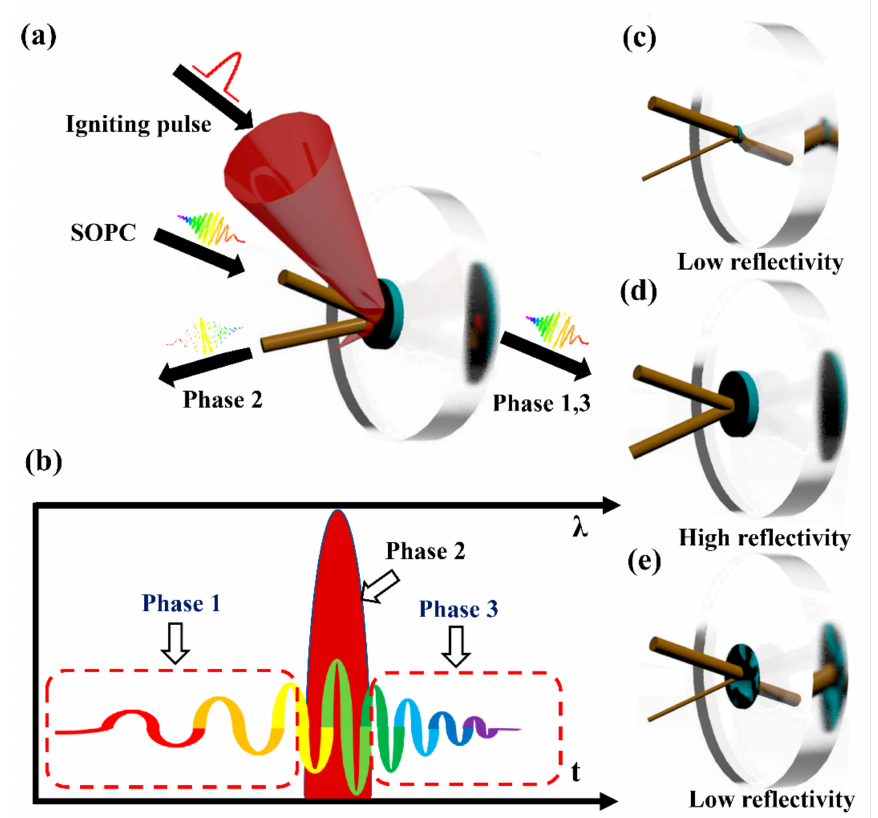
Figure 1. Schematic diagram of temporal contrast enhancement measurement by a spatiotemporally overlapped chirped pulse (SOCP): ( a ) Concept of SOCP. ( b ) Temporal diagram of SOCP and igniting pulse. ( c ) Phase 1: low reflectivity. ( d ) Phase 2: high reflectivity. ( e ) Phase 3: low